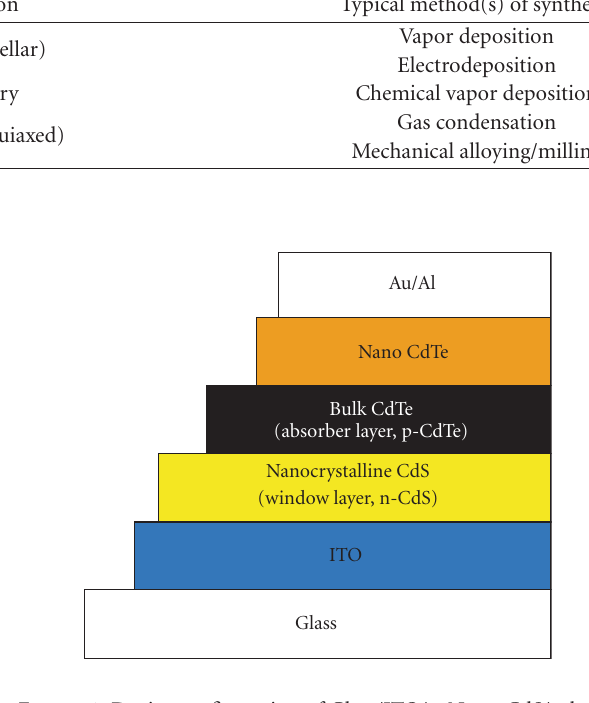
Figure 1: Device configuration of Glass/ITO/n-Nano-CdS/p-bulk- CdTe/nano CdTe/Au/Al solar cell